Question: Does the figure show an increasing or a decreasing trend?
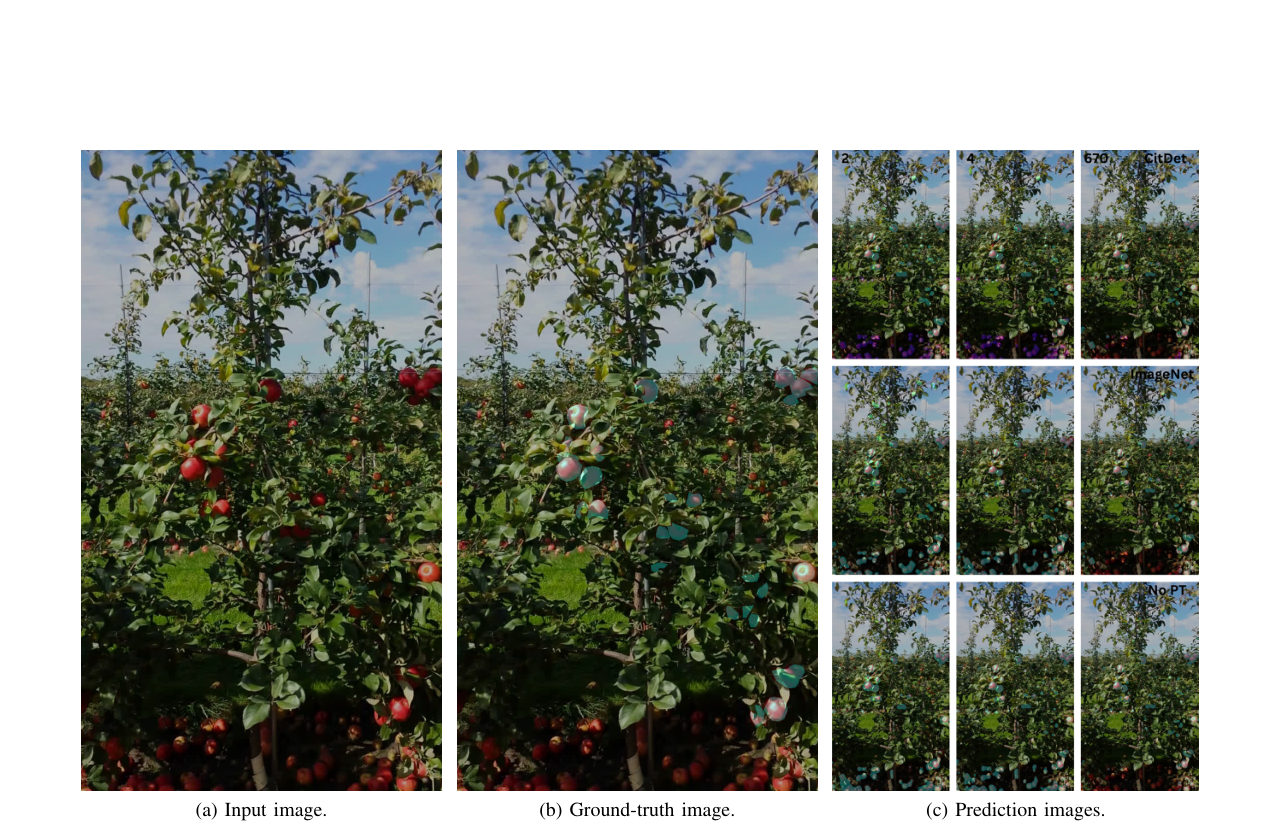
Answer: increasing